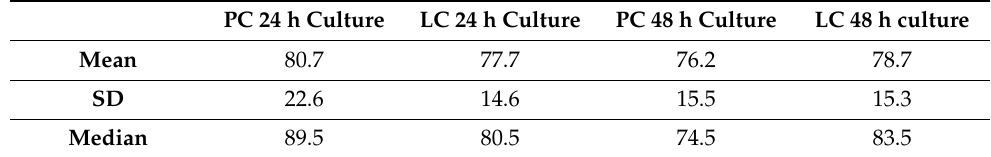
Table 3. Post-thaw cell viability (%) after 24 and 48 h of culture—rapid thawing protocol.